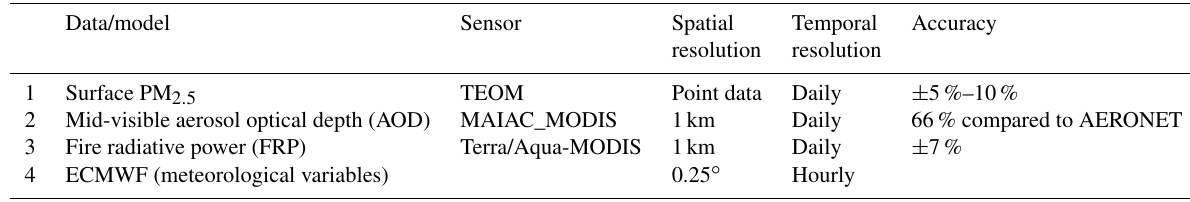
Table 1. Datasets used in the study with sources. Data/model Sensor Spatial Temporal Accuracy resolution resolution 1 Surface PM 2 . 5 TEOM Point data Daily 2 Mid-visible aerosol optical depth (AOD) MAIAC_MODIS 1km Daily 66% compared to AERONET 3 Fire radiative power (FRP) Terra/Aqua-MODIS 1km 4 ECMWF (meteorological variables) 0.25